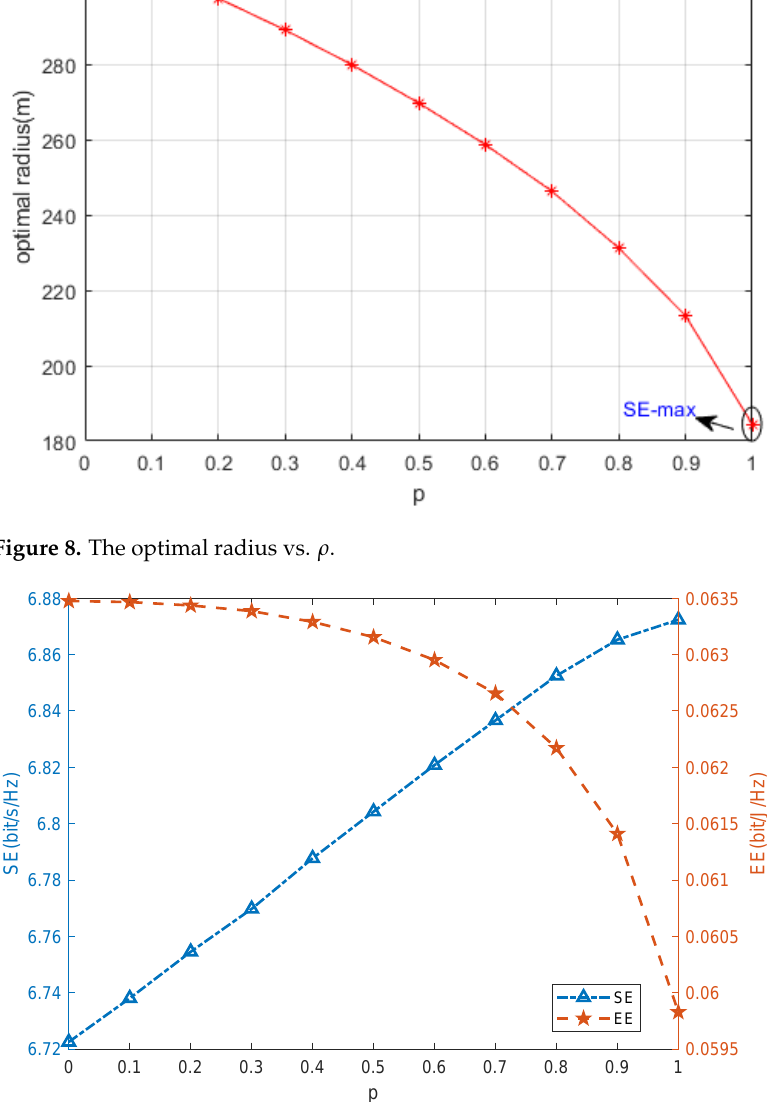
Figure 9. SE-EE trade-off in UAV-enabled mobile relaying